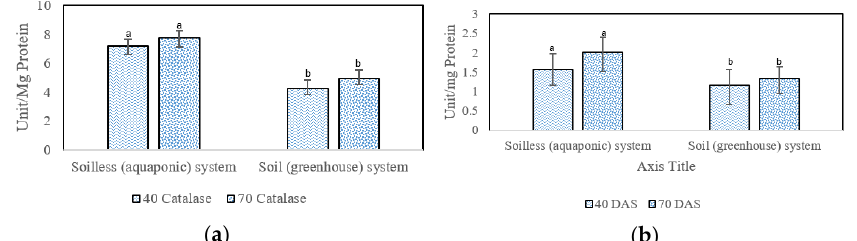
Figure 5. Catalase ( a ) and peroxidase ( b ) activities of Ocimum basilicum in soilless (aquaponic) and soil (greenhouse) systems at 40 and 70 DAS. Values are given as mean ± SD of seven samples in each group. Values that do not share a common superscript (a,b) differ significantly at p ≤ 0.05 using t -test.